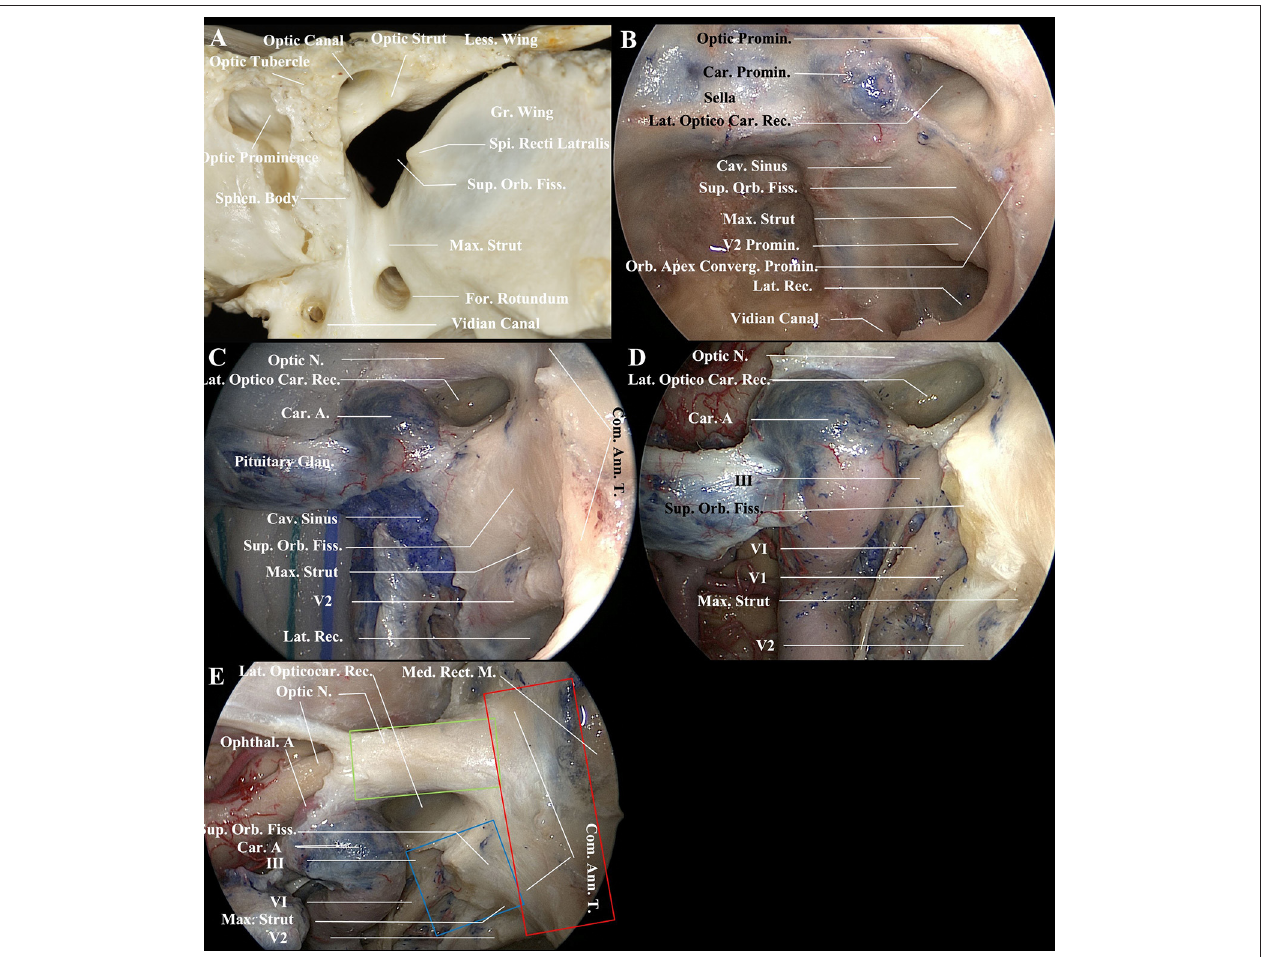
FIGURE 2 | Endoscopic endonasal views of the medial wall of the orbital apex and the lateral wall of the sphenoid sinus (left side). (A) The osseous optic apex consists of the optic canal superomedially and the superior orbital fissure inferolaterally. The contents of the superior orbital fissure are separated from the optic nerve and ophthalmic artery, which pass through the optic canal, by the optic strut superiorly. In addition, they are separated from the maxillary division of the trigeminal nerve that courses by the foramen rotundum by the maxillary strut inferiorly. (B) Endoscopic endonasal view of the lateral wall of the sphenoid sinus. From superior to inferior, the lateral wall of the sphenoid sinus contains the prominences of the optic nerve, the internal carotid artery, the superior orbital fissure, and the maxillary division of the trigeminal nerve. The orbital apex convergence prominence, at which the contents of the optic canal and the superior orbital fissure converge, is located at the junction of the lateral wall of the sphenoid sinus and the orbit plate of the ethmoid bone (lamina papyracea). Between these prominences are bony recesses or depressions. The medial surface of the optic strut is the base of the lateral opticocarotid recess. The medial surface of the maxillary strut is the maxillary depression of the lateral wall of the sphenoid sinus. (C) View of the optic nerve, the superior orbital fissure, and the maxillary division of the trigeminal nerve after removal of the bone of the lateral wall of the sphenoid sinus. The anteroinferior compartment of the cavernous sinus, indicating the posterior boundary of the medial wall of the superior orbital fissure, was incised. The common annular tendon was indicative of the orbital apex convergence portion (the proper orbital apex). (D) Removal of the periosteum and periorbita of the medial wall of the superior orbital fissure and part of the cavernous sinus to identify cranial nerves III, VI, V1, and V2 and adipose tissue of the orbital apex. (E) A 45-degree endoscopic endonasal view of the proper orbital apex, optic nerve (intracanal segment), and superior orbital fissure contents. The optic nerve superiorly (green line box) and the superior orbital fissure contents inferiorly (blue line box) converge into the convergence portion (the proper orbital apex) anteriorly (red line box). The configurations of these three structures form a π -shaped configuration after clockwise rotation of 90 degrees . A., Artery; Ann., Annual; Car., Carotid; Cav., Cavernous; Com., Common; Converg., convergence; Fiss., Fissure; For., Foramen; Glan., Gland; Gr., Greater; Lat., Lateralis; Less., Lessor; M.,